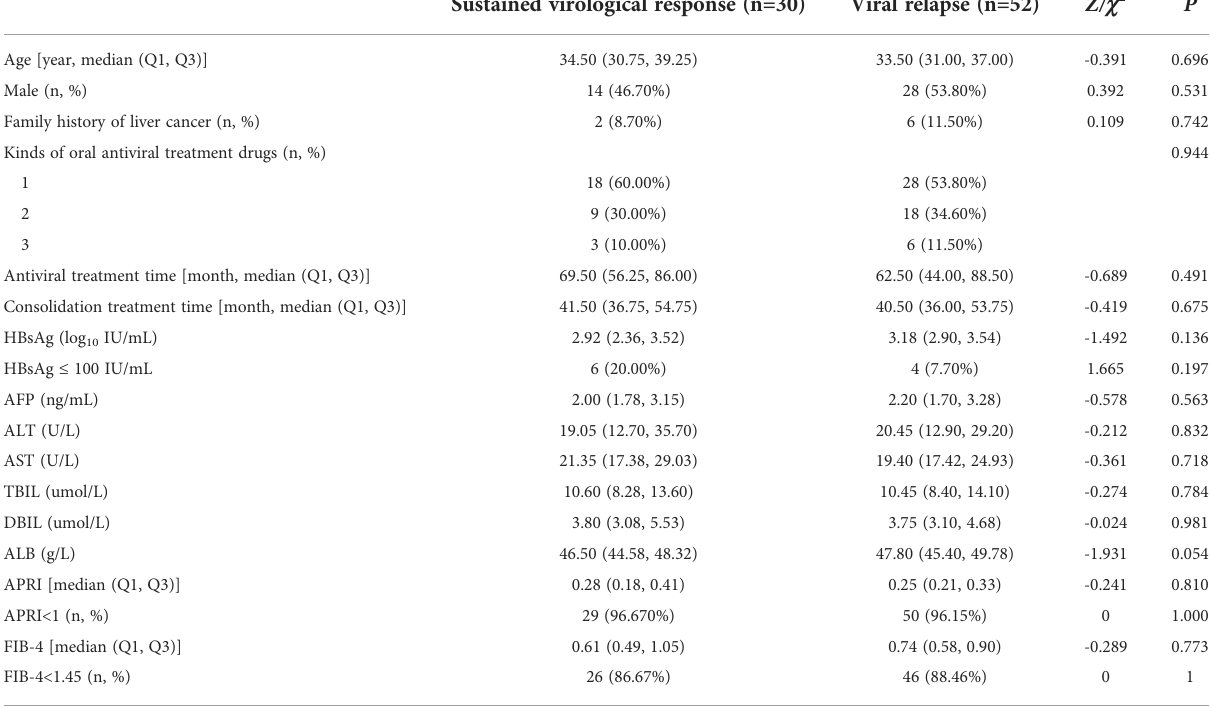
TABLE 2 Characteristic of patients with sustained virological response and Viral relapse at